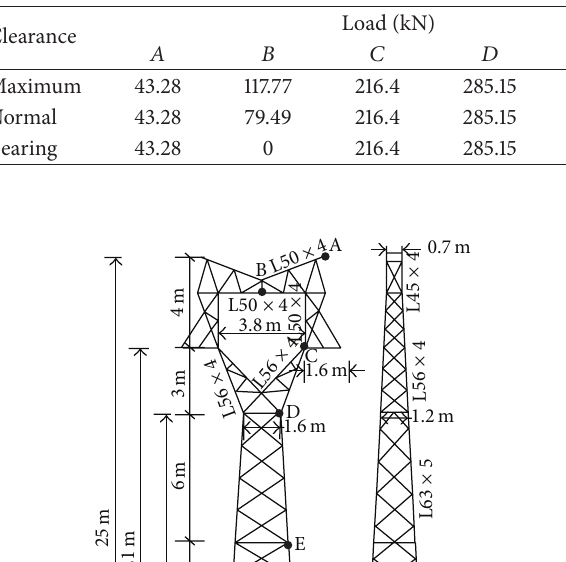
Table 2: Ungkurapinan et al. lap-splice bolted joint model [18].